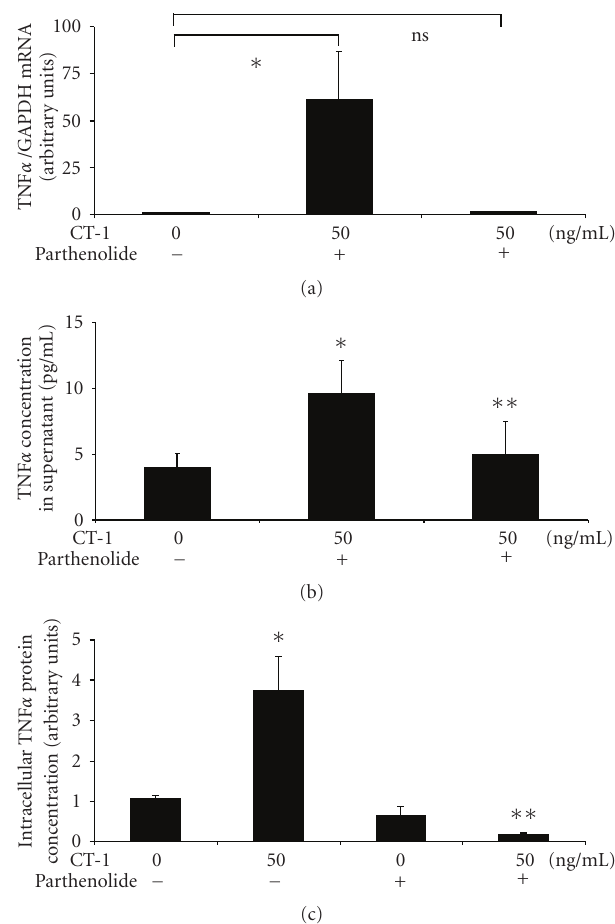
Figure 6: E ff ect of parthenolide on CT-1 induced TNF α expression. (a) Human PBMCs were incubated with CT-1 (50ng/ml) for 1hour in the presence of parthenolide. Afterwards cells were lysed and TNF α mRNA expression was determined by real-time-PCR. All TNF α mRNA expression data were normalized to GAPDH. n = 6, data are expressed as mean ± SEM. ∗ P < . 05 compared to unstimulated cells. (b) Human PBMCs were incubated with CT-1 (50 ng/ml) for 3hours in the presence of parthenolide. Afterwards TNF α protein concentration in the supernatant was determined by ELISA. n = 5, data are expressed as mean ± SEM and normalized to unstimulated cells. ∗ P < . 05 compared to unstimulated cells. ∗∗ not significant compared to unstimulated cells. (c) Analysis of intracellular TNF α production using immunofluorescent flow cytometry. Human blood was incubated with 50ng/ml CT-1 for 6 hours in the presence of brefeldin A and parthenolide. Afterwards erythrocytes were lysed and cells were stained with a monoclonal antibody against CD14 FITC-conjugated and against TNF α PE- conjugated. Monocytes were gated and results are expressed normalised to unstimlulated monocytes. n = 6, data are expressed as mean ± SEM. ∗ P < . 05 compared to unstimulated cells, ∗∗ P < . 05 compared to cells stimulated with 50ng/ml